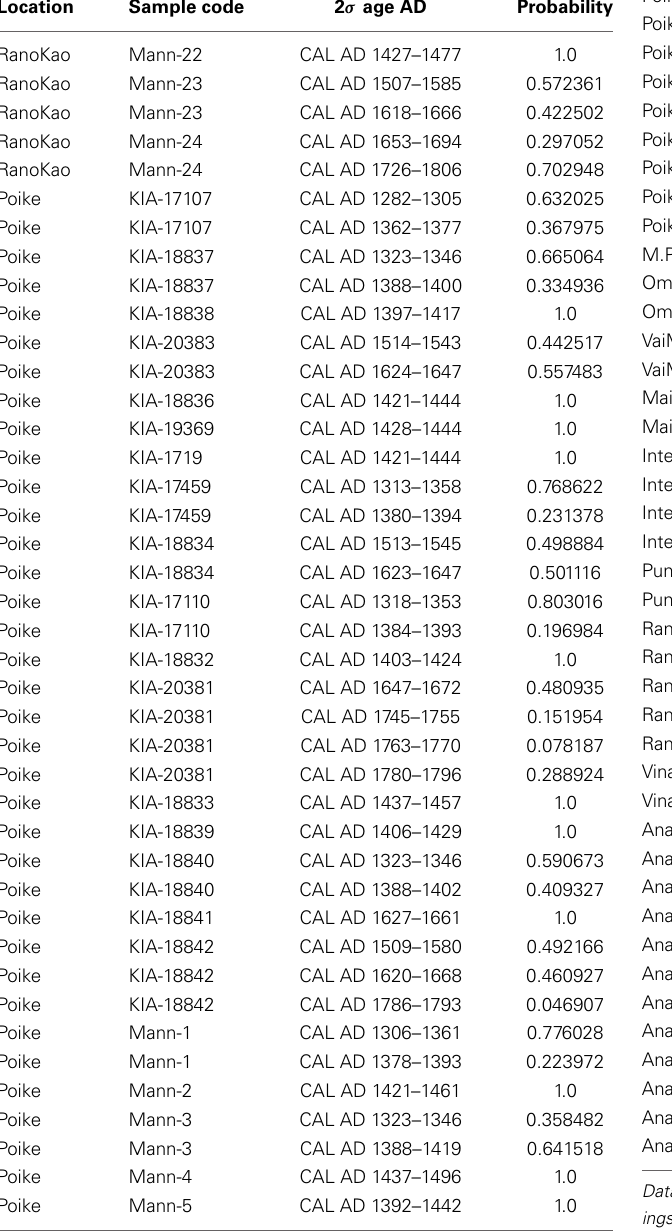
Table A1 | Radiocarbon dates associated with wood charcoal, Jubaea palms, and/or truncated primeval